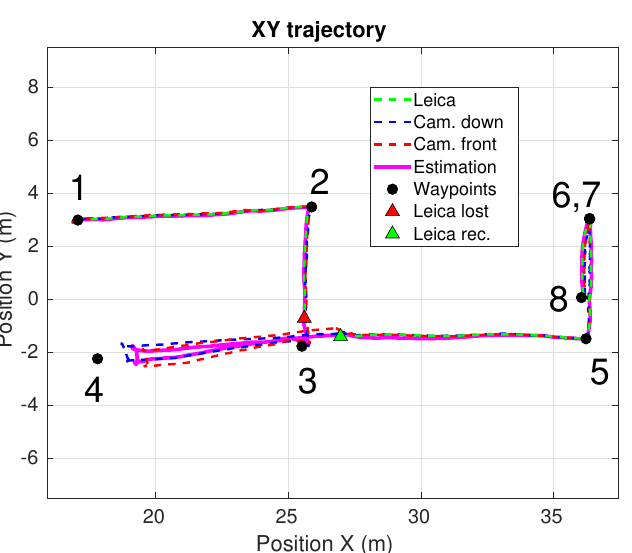
Figure 8. Top view of the estimated UAV trajectory during Experiment 2. The estimation computed by our localization system (magenta), as well as the estimations provided separately by each of the calibrated cameras (blue and red) and the total station (green) before the fusion, are depicted. The additional markers label the inspection waypoints and the points where the total station fails and is recovered, respectively.